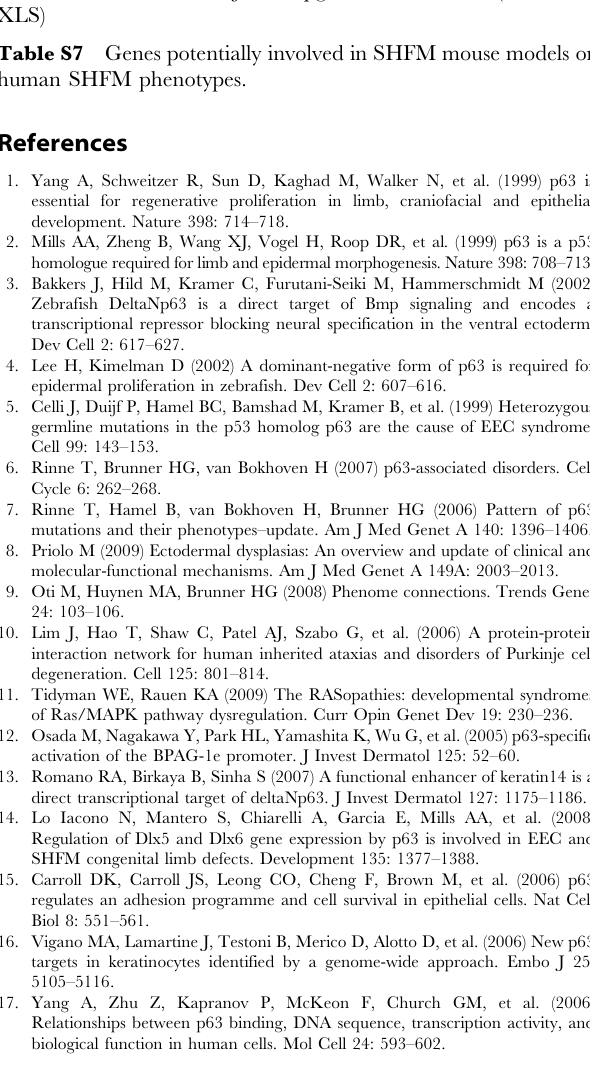
Table S6 Affected features in p63 potential target gene- associated diseases (PTG-associated diseases).